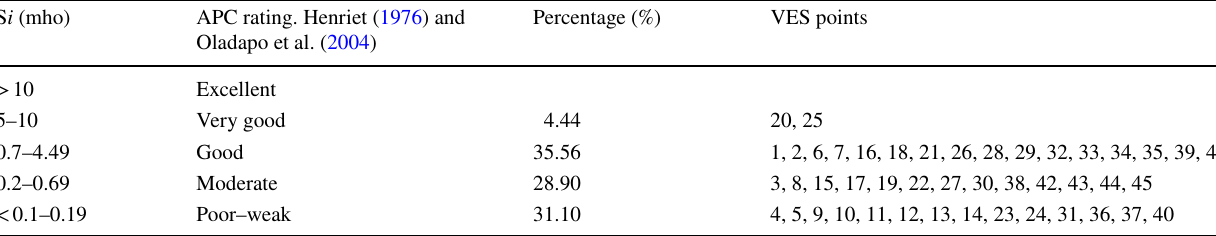
Table 2 Longitudinal conductance (mho) and aquifer protective capacity rating S i (mho) APC rating. Henriet (1976) and Oladapo et al. (2004)